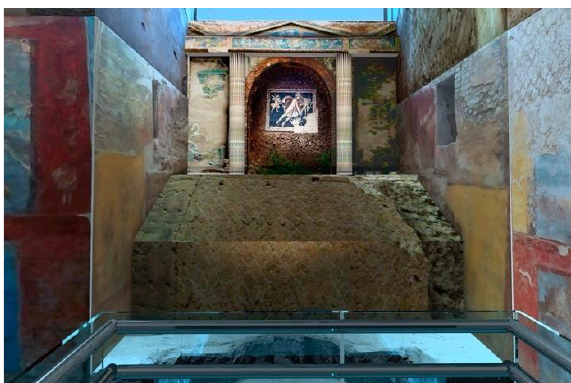
Figure 15. Lighting studies on the Ninfeo niche in the frigidarium of the Suburban Thermal Baths.